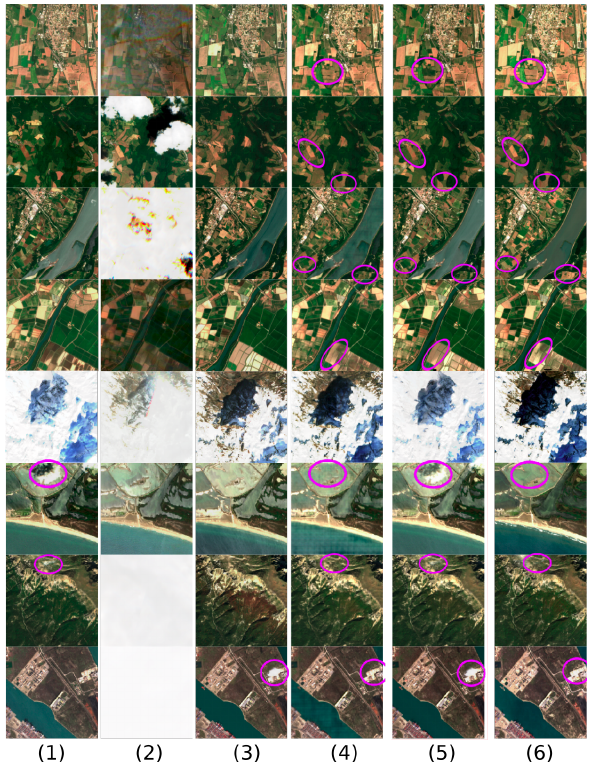
Figure 12. From left to right: input images S 2 t − 1 (1), S 2 t (2), S 2 t +1 (3), output reconstructed optical images (cid:100) S 2 t from MSOP unet + DEM (4), the Gap-filling (5), and the reference image S 2 t (cid:48) (6). In violet are circled details in the reconstructed images that the gap-filling fails to retrieve, or artifacts caused by wrong could masks in input